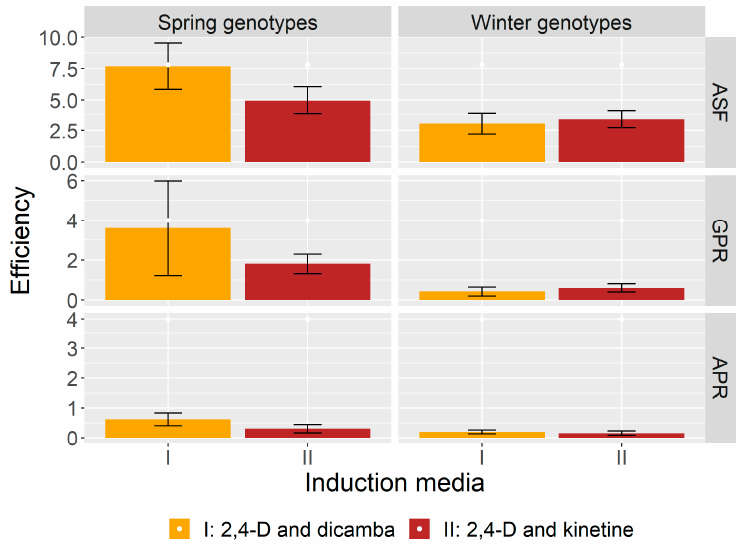
Figure 2. The e ffi ciency of androgenic structures formation (ASF), green plants regeneration (GPR) and albino plants regeneration (APR) of the spring and winter genotypes according to the type of growth hormones in the induction media (I—containing auxins only and II—containing auxin and cytokinin); mean value ± standard error of mean (SEM). Table 2. A comparison of the e ffi ciency of androgenic structures formation (ASF), green plants regeneration (GPR) and albino plants regeneration (APR) of the spring and winter varieties according to the type of growth hormones in the induction media based on right-sided Wilcoxon test. I Induction Medium (2.4-D and Dicamba)—The Right-Sided Wilcoxon Test Parameters The Value of Wilcoxon’s Statistics p -Value ASF (no of androgenic structures / 100 plated anthers) 177.0 0.004 ** GPR (no of green plants regeneration / 100 plated anthers) 160.0 0.020 * APR (no of albino plants regeneration / 100 plated anthers) 140.5 0.109 II Induction Medium (2.4-D and Kinetine)—The Right-Sided Wilcoxon Test Parameters The Value of Wilcoxon’s Statistics p -Value ASF (no of androgenic structures / 100 plated anthers) 128.5 0.260 GPR (no of green plants regeneration / 100 plated anthers) 154.5 0.040 * APR (no of albino plants regeneration / 100 plated anthers) 126.0